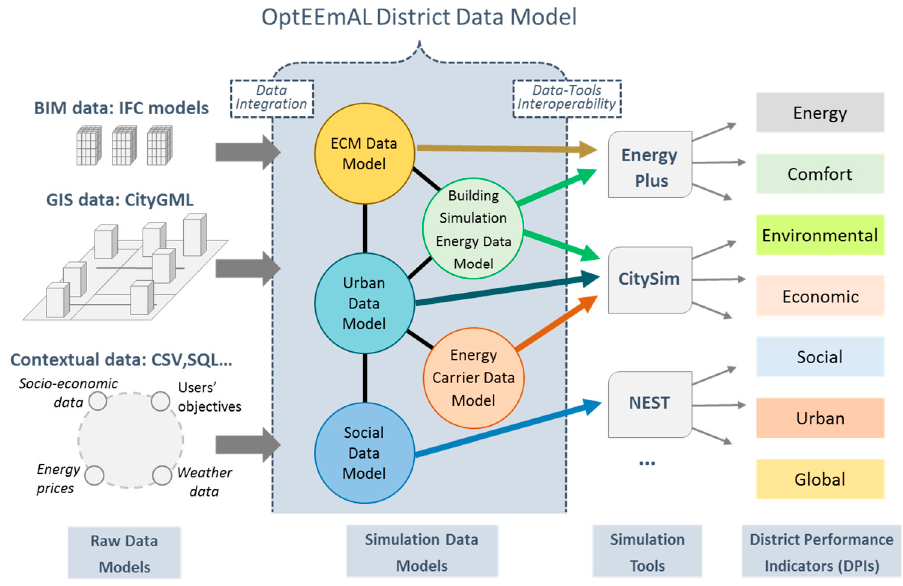
Figure 1. Conceptualization of the District Data